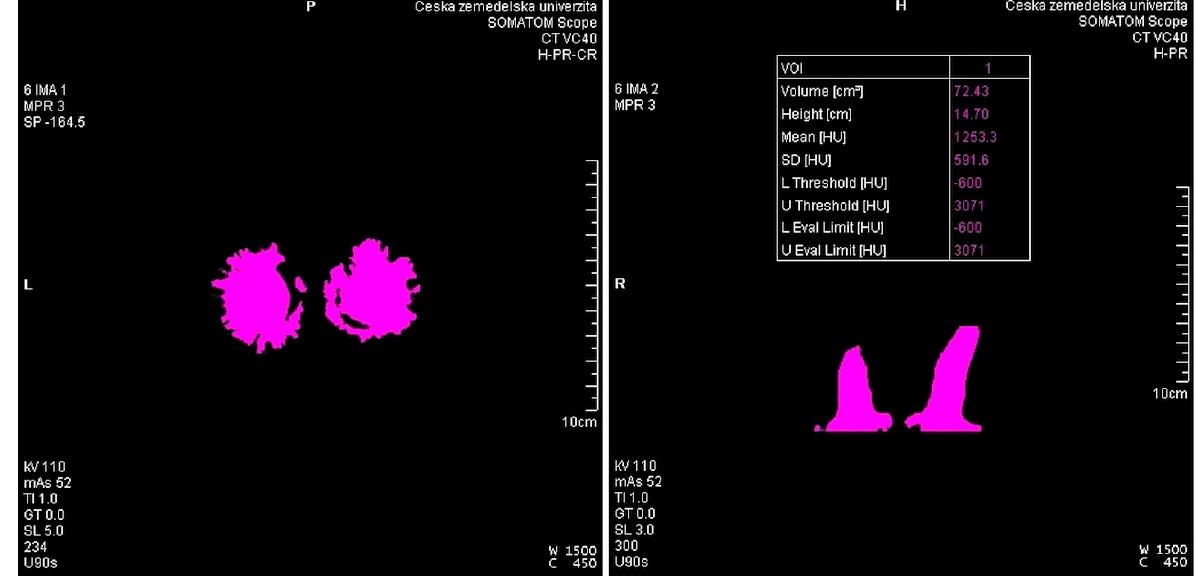
Figure 5. Measuring antler volume with a CT scanner.